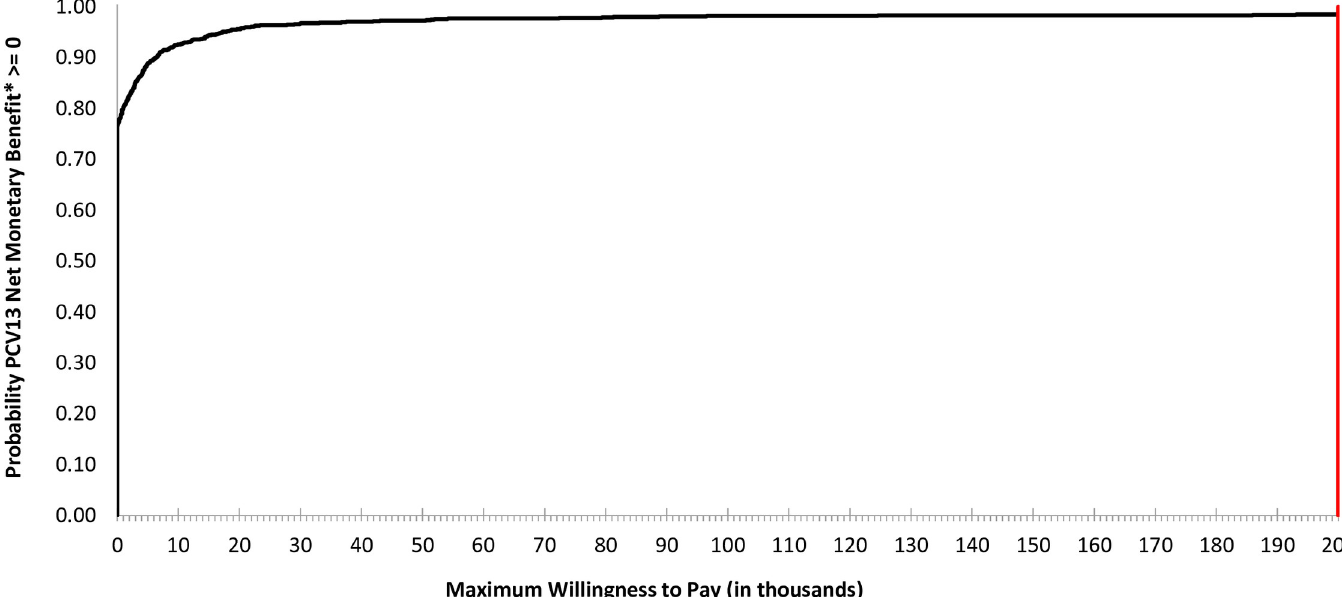
Fig 12. Cost-effectiveness acceptability curve: Private health care sector HIV-infected model. Costs are indicated in 2015 South African rand.